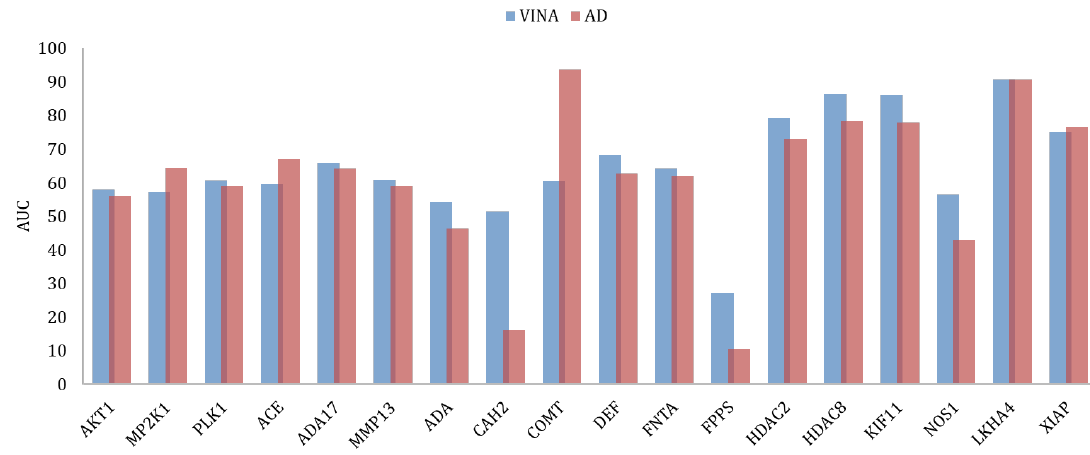
Figure 4. Average AUC calculated for the various metalloenzymes, obtained with Vina and AutoDock.